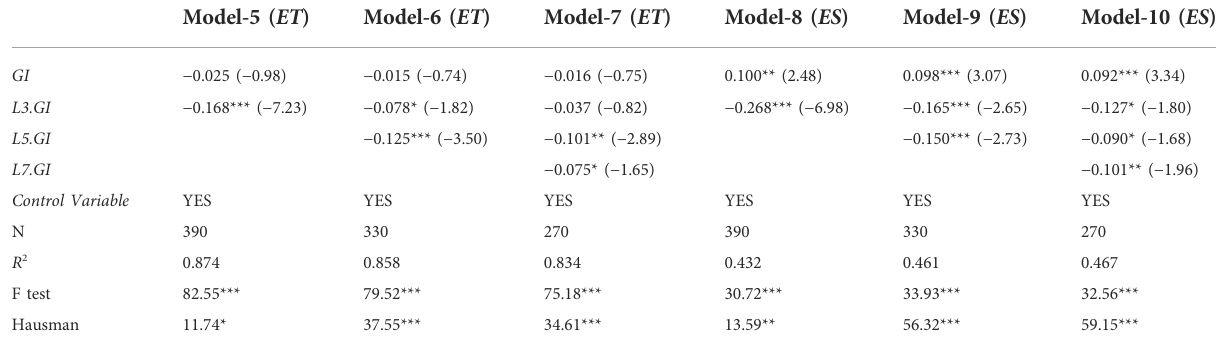
TABLE 3 Short-term and long-term